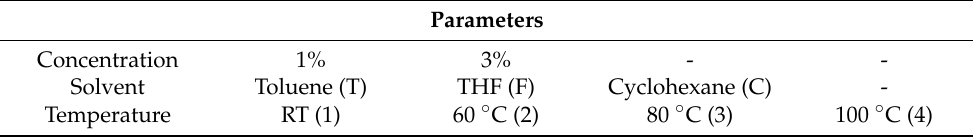
Table is divided for the four different samples on the basis of concentration (1 wt%) and (3 wt%). The abbreviations for each sample are referred to in an XY format, where X denotes the temperature and Y denotes the solvent. All parameters (concentration, solvent type, and temperature) are listed in Table 4. Table 4. Different parameters used for all samples with appropriate abbreviations, as used in Table